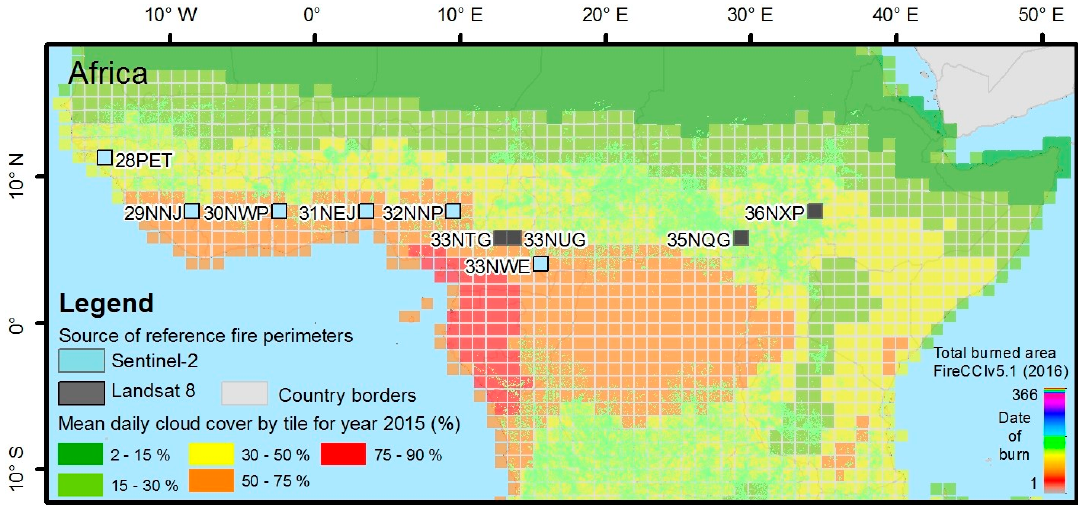
Figure 1. Tiles used for inter-comparison together with the mean daily cloud cover (2015) and the total burned (2016), according to the FireCCI5.1 global product. The source of the optical imagery used to generate the reference fire perimeters for each of the analysed tiles is also shown. Table 1. Military Grid Reference System (MGRS) tiles used for inter-comparison. The main land cover type (from CCI Land Cover product, 2015) and the total burned area. The sensor used to generate the reference fire perimeters was labelled S for Sentinel-2 and L for Landsat-8.